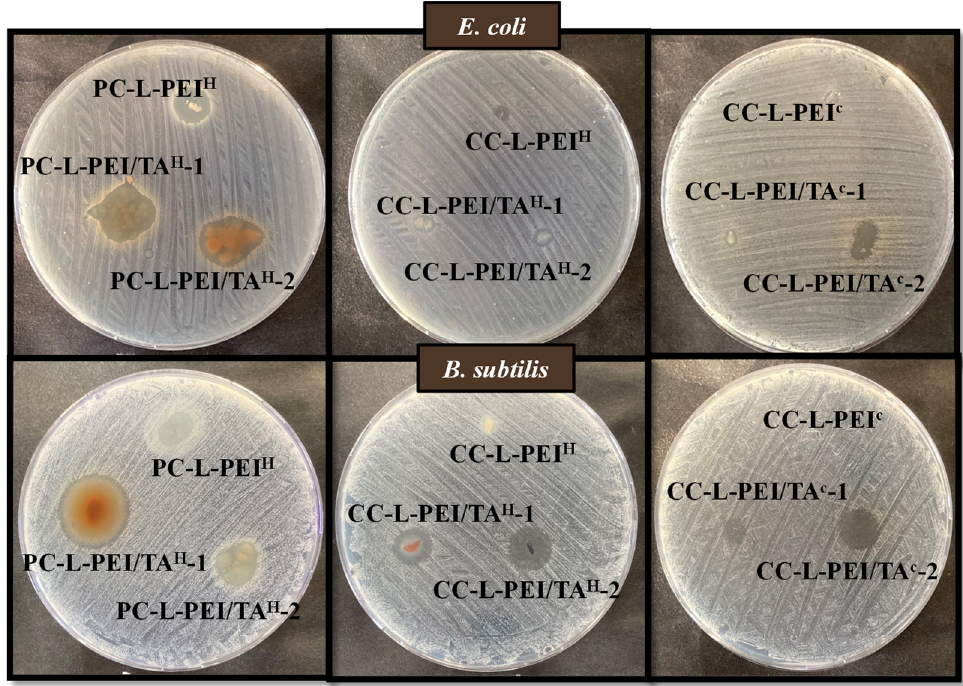
Figure 6. Zone of inhibition images of L-PEI-based hydrogel/cryogel samples weighing 1.5 mg against E. coli and B. subtilis.